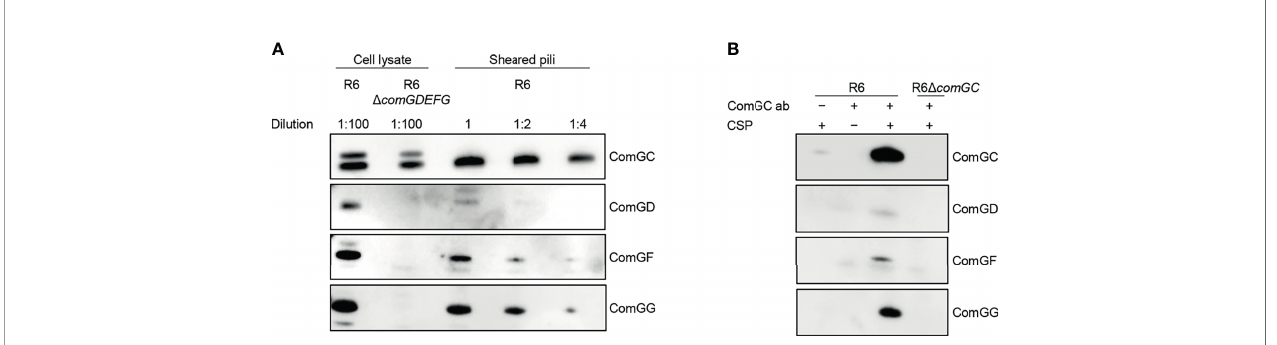
FIGURE 4 | Localization of ComGD, ComGF and ComGG. (A) Whole-cell lysate (diluted 1:100) and the sheared fraction (2-fold serial dilutions as indicated) from WT R6 were analysed by immunoblotting with antisera speci fi c for ComGC, ComGD, ComGF and ComGG. The lysate from a strain lacking all four minor pilins (R6 D comGDEFG ) was included as a negative control and indicates the speci fi city of detection. (B) Co-immunoprecipitation of sheared pili from WT R6 strain using anti-ComGC antibodies (ComGC ab). As negative controls a non-induced culture (-CSP), a no antibody control (-ComGC ab) and a strain lacking the major pilin ( R6 D comGC ) were included. IP samples were probed for the presence of ComGC, ComGD, ComGF and ComGG by